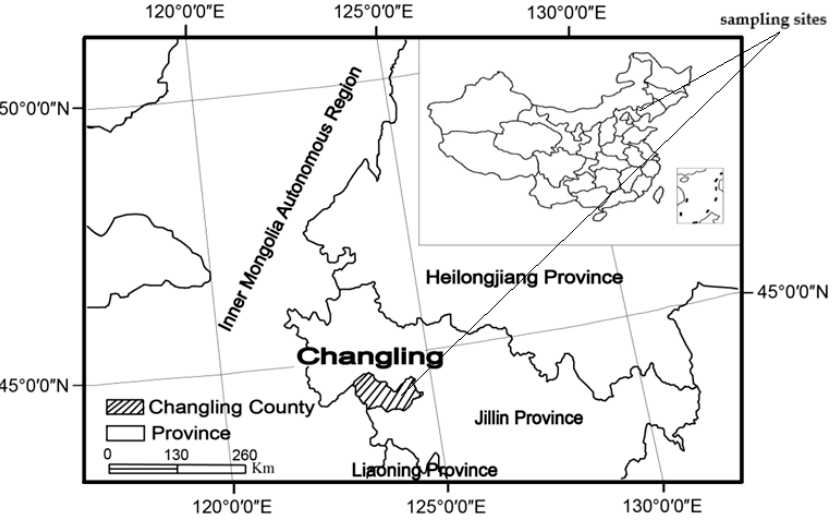
Figure 1. Map of the locations of the sampling sites.